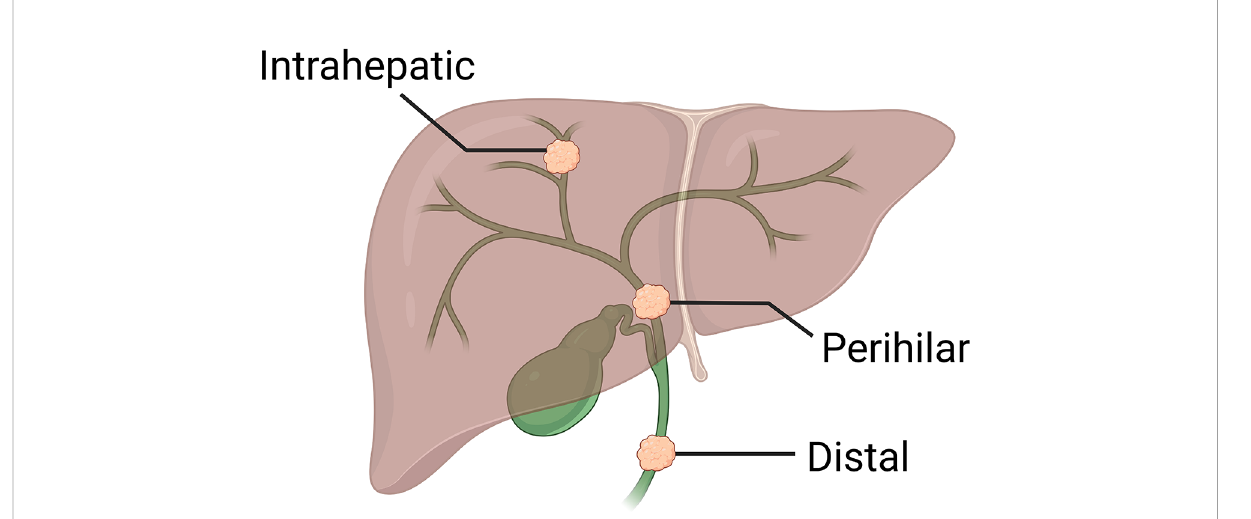
FIGURE 1 Three anatomical subtypes of